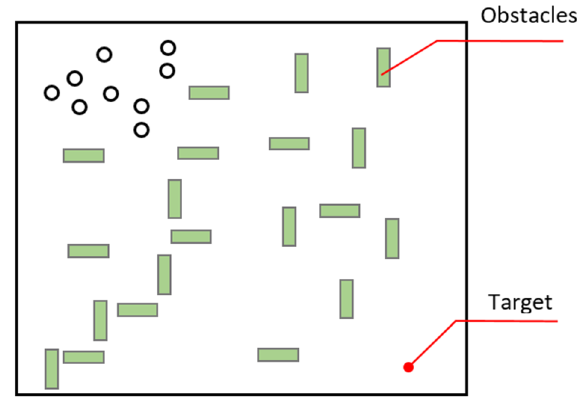
Algorithm 5 Solution: Obstacles in the working